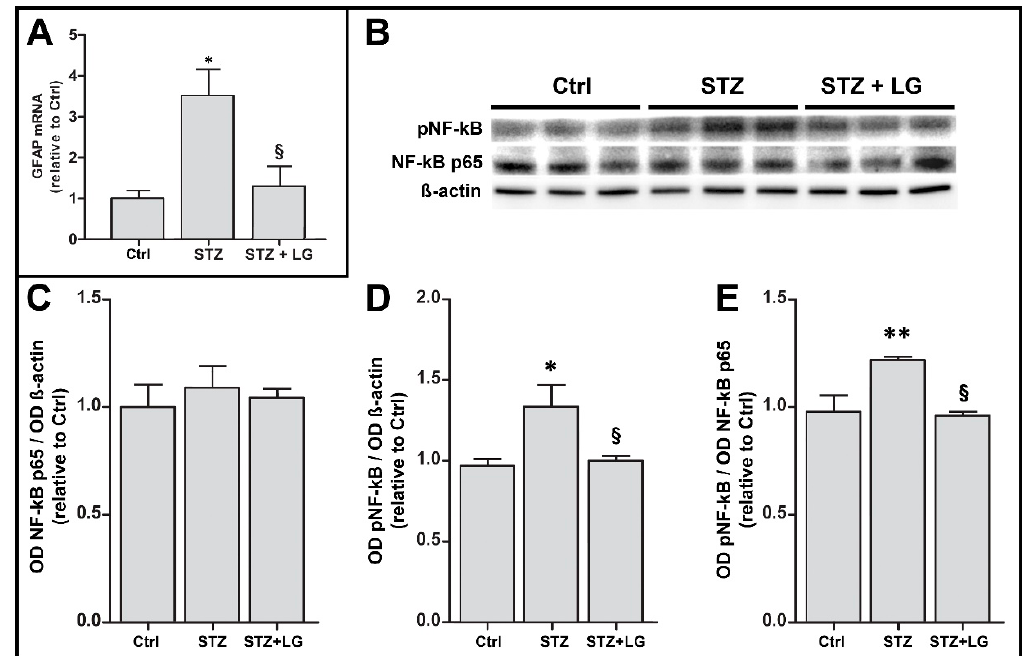
Figure 11. Effects of LG on inflammatory markers. ( A ) GFAP mRNA expression evaluated with qPCR in control retinas and in retinas of STZ rats with or without LG treatment. ( B ) Western blots showing immunoreactive bands of NF-kB, of pNF-kB and of ß-actin, used as an internal standard, i n control rat retinas and in retinas of STZ rats with or without LG treatment. ( C,D,E ) Graphs representing the ODs of the immunoreactive bands to quantify the protein expression of NF-kB ( C ), that of pNF-kB ( D ), and the ratio pNF-kB /NF-kB as a measure of NF-kB activation ( E ). Each column represents mean ± SD. * p < 0.05 vs. Ctrl; ** p < 0.01 vs. Ctrl; § p < 0.05 vs. STZ; n = 3 for all measures. Power value: 0.80